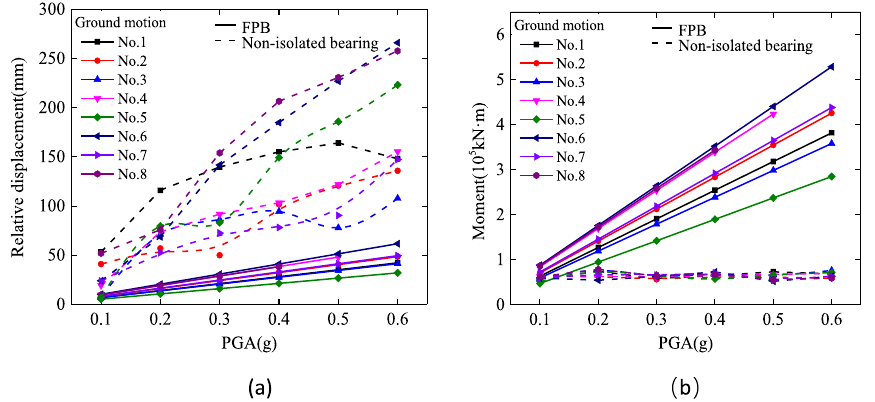
Fig. 22 IDA results of the bridge response: a relative displacement of the bridge deck; and b moment at pier bottom